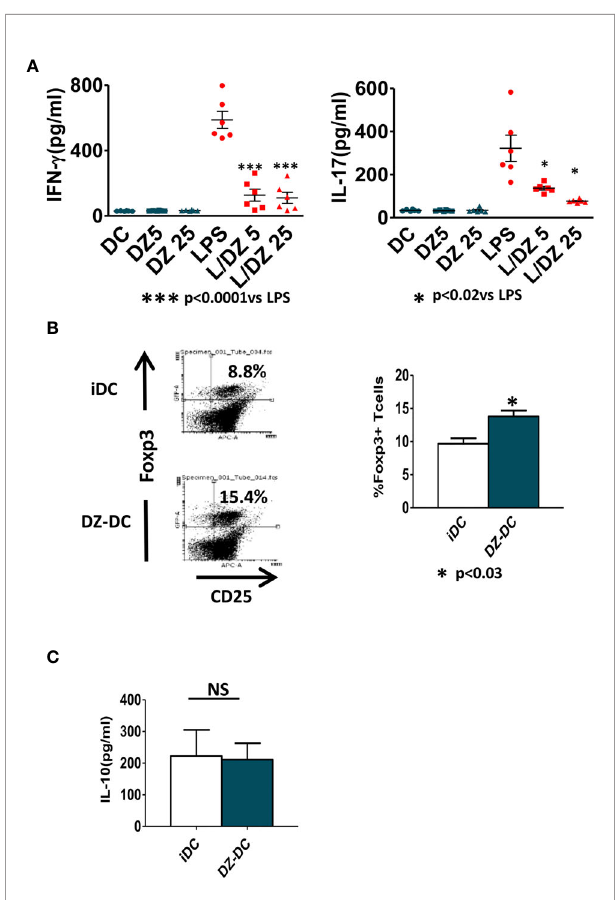
FIGURE 4 | Impaired ability of Diazepam (DZ)-treated dendritic cells (DCs) to initiate allogeneic in fl ammatory responses. (A) C57BL/6 bone marrow-derived DCs (1.5 × 10 6 /ml) were pre-incubated with LPS and DZ for 18 h, washed, and co-cultured with allogeneic splenocytes (SP) from BALB/c mice during 5 days at DC : SP relation of 1:20. IFN- g and IL17 levels were determined by ELISA in supernatants. (B) Balb/c bone marrow-derived DCs (1 × 10 6 ) untreated or treated with DZ (25 µM) were injected i.p. in C57BL/6-Foxp3-GFP reporter mice (n = 3). At day 15 post-injection, the mice were sacri fi ced, and the determination of CD4+CD25+GFP+cells on spleen cell population was evaluated by fl ow cytometry. (C) Splenocytes from iDC and DZ-DC treated mice were cultured for 24 h in the presence of PMA, and IL-10 production was evaluated by ELISA test on culture supernatants. These data are representative of at least three experiments. Signi fi cant differences are indicated by * p < 0.05, *** p < 0.001. Non-signi fi cant values are expressed as